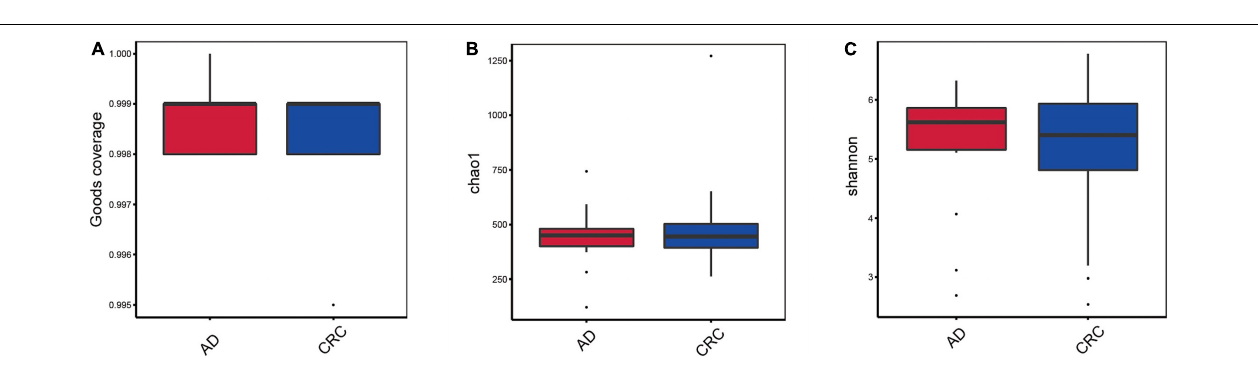
FIGURE 1 | (A) Venn diagram illustrating the total, unique, and shared number of OTUs predicted for AD and CRC group datasets; (B) Rarefaction curve of OTU; (C) Species accumulation boxplot.